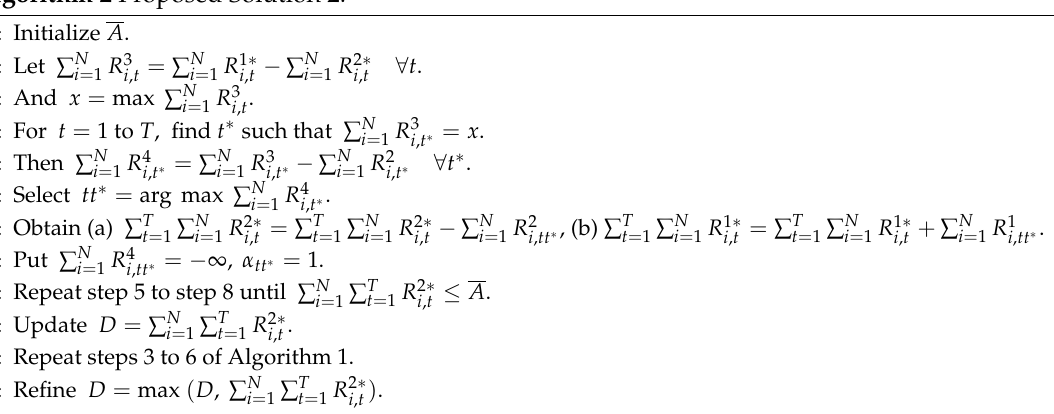
Algorithm 2 Proposed Solution